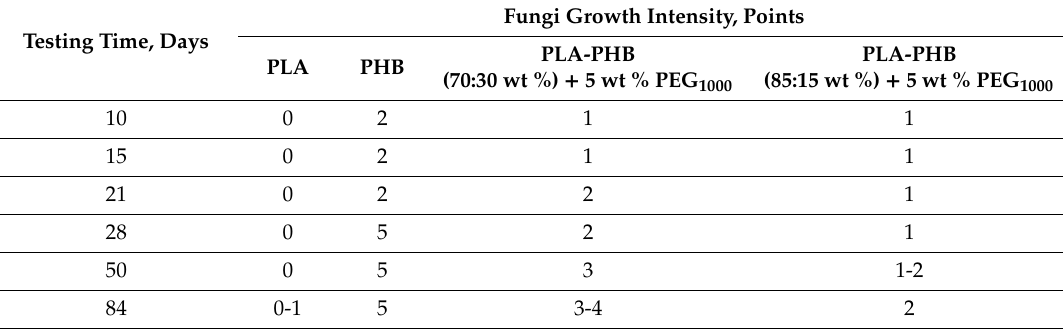
Table 3. Fungi resistance of samples in points depending on testing